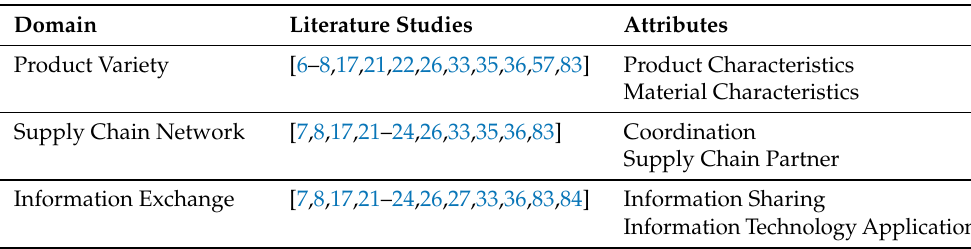
Table 1. Conceptual modeling framework based on several literature studies and defining attributes for each domain to support the